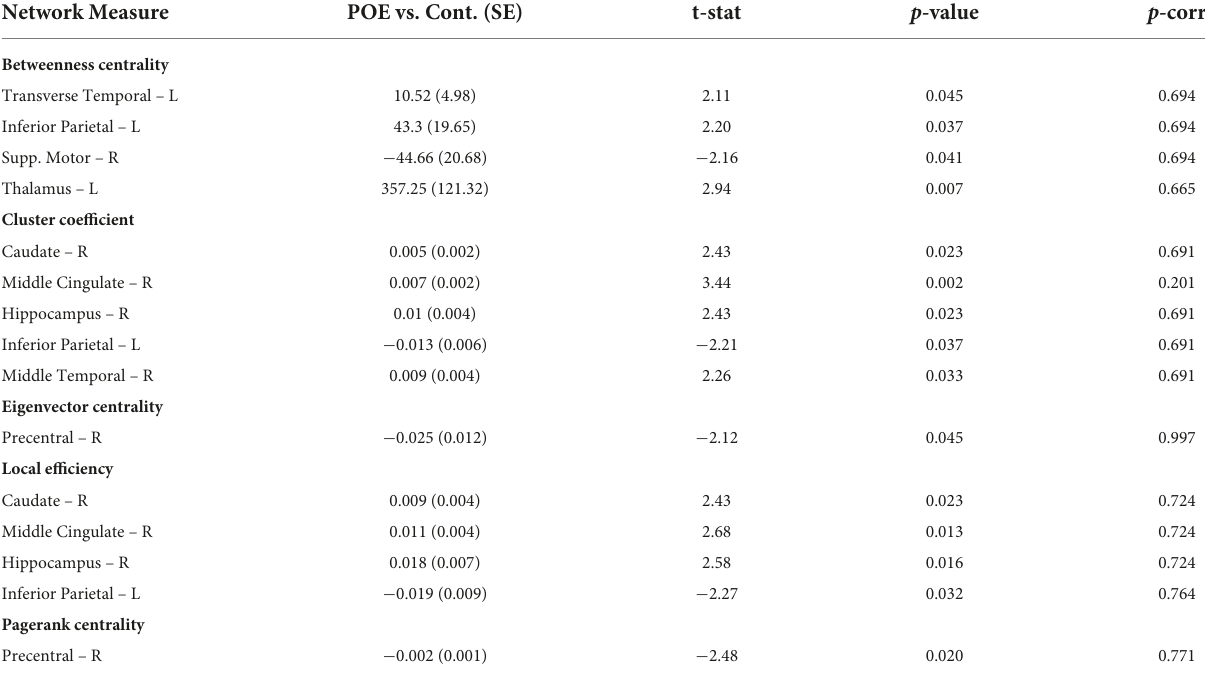
TABLE 4 Network measures between POE and opioid naïve infants based on fiber